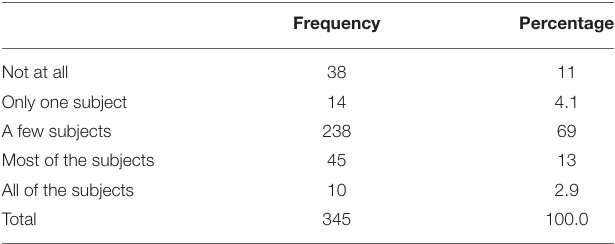
TABLE 7 | The course that too challenging for students through online